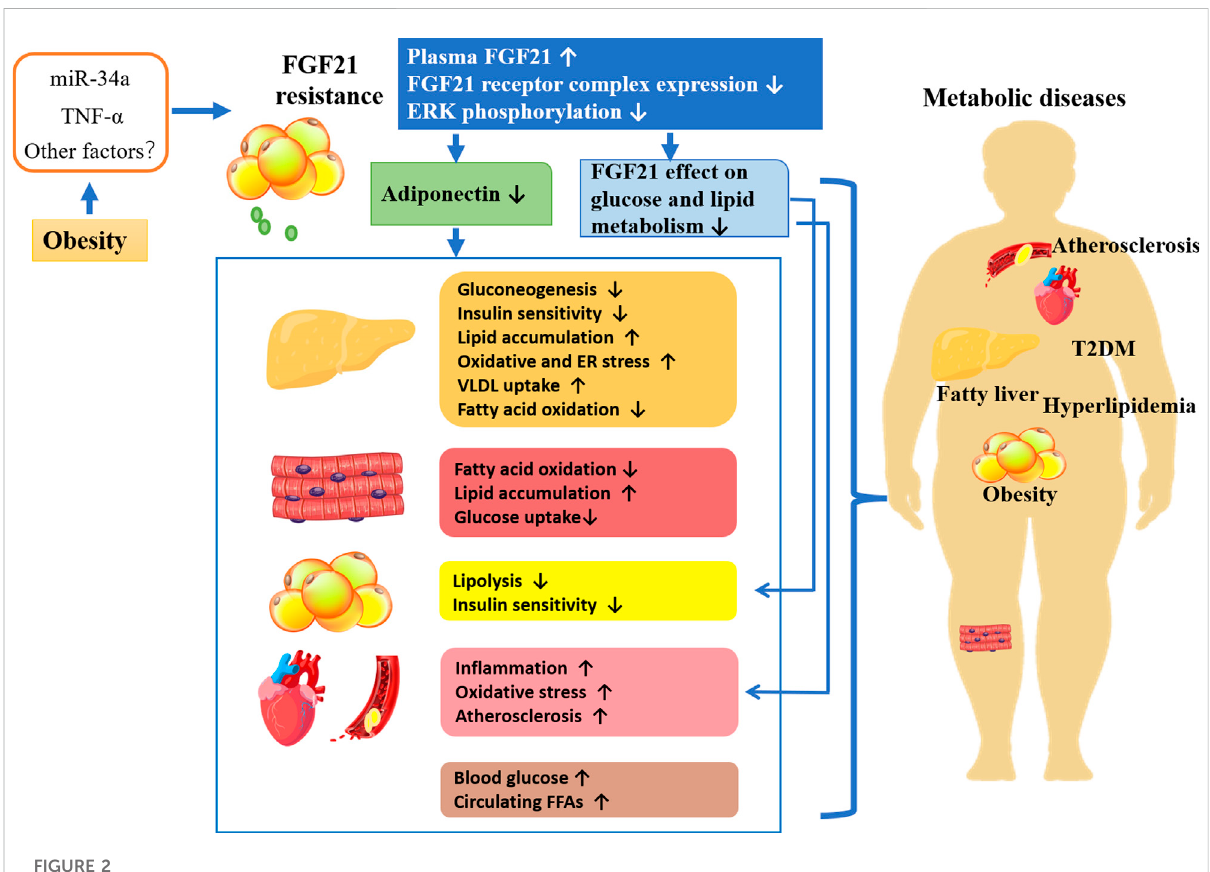
FIGURE 2 FGF21 resistance, the potential mechanism leading to metabolic